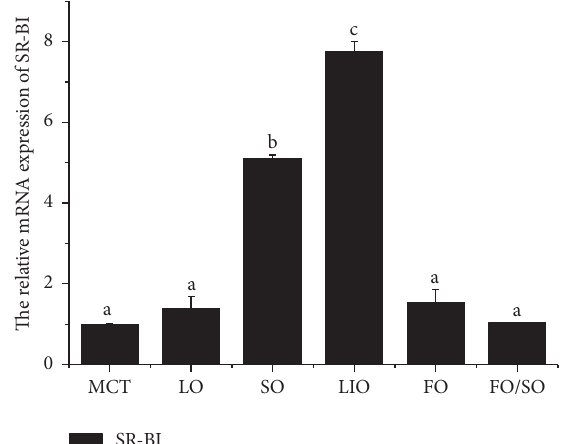
Figure 5: MnSR-BI mRNA expression in the hepatopancreas of M. nipponense fed different dietary lipid sources for 56 days. Bars represent mean ± SD ( 𝑛 = 3 ). Bars with different letters differ significantly ( 𝑃 < 0.05 ).